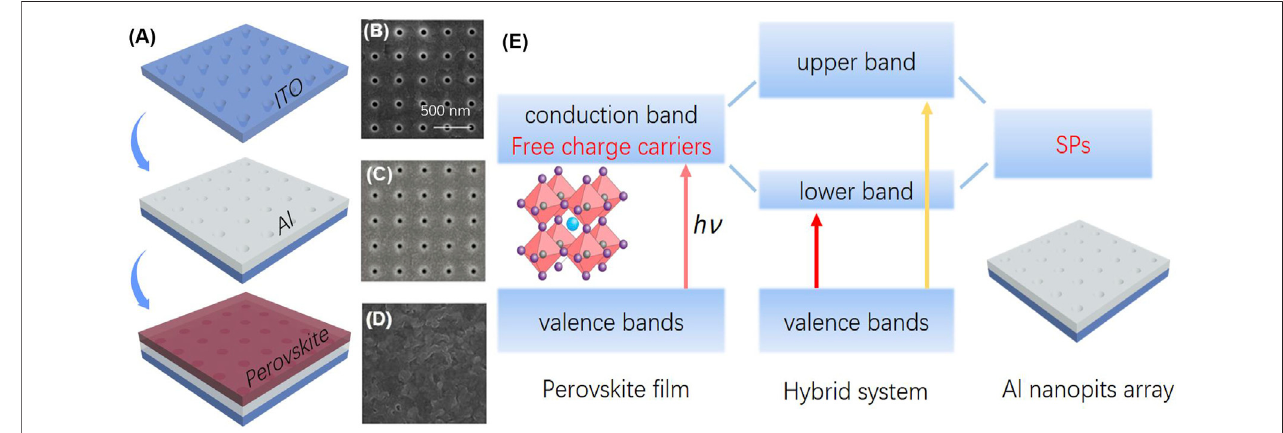
FIGURE1|(A) Stepsoffabrication ofstrong freechargecarrier – SPcoupling system, (B,C) SEMimageoftheconicalnanopits onglass/ITOand Allayer, (D) SEM image of perovskite layer, (E) the mode diagram of the hybrid free charge carrier – SP system; the inset shows the crystal structure of CH 3 NH 3 PbCl x I 3-x perovskite.